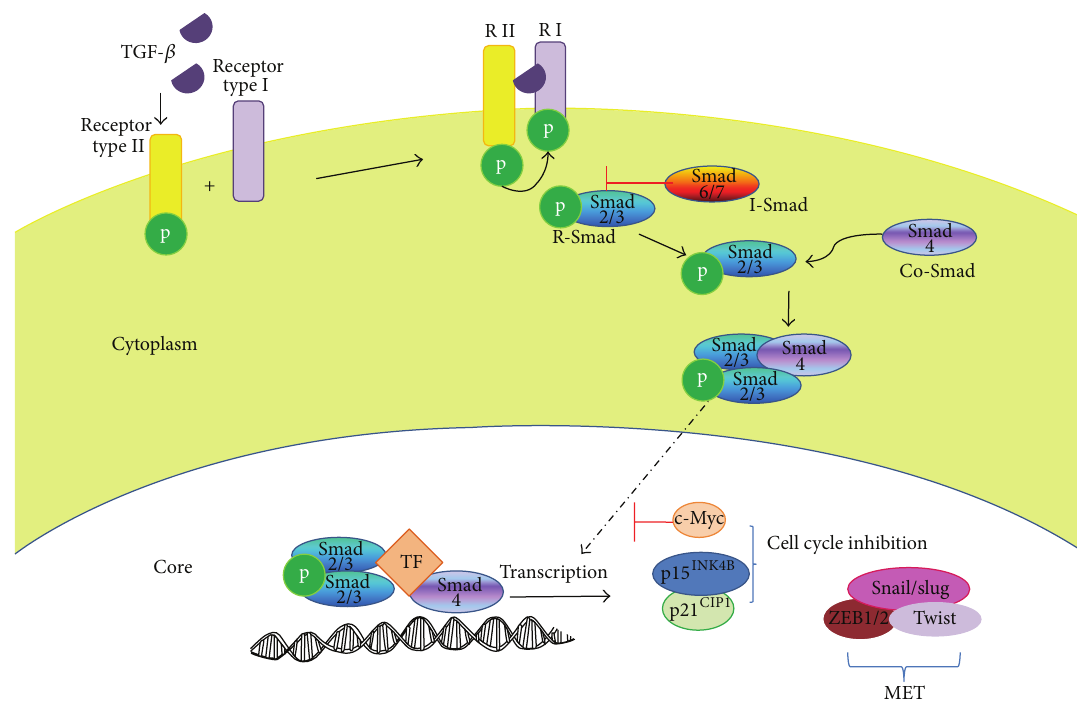
Figure 2: The TGF- 𝛽 canonical signaling pathway. After the ligand binds to T 𝛽 RII, the TGF- 𝛽 receptors are dimerized and recruit Smad proteins. The Smad2 and/or Smad3 complex is phosphorylated by T 𝛽 RI and forms a complex with Smad4. This complex subsequently translocates to the nucleus where it binds to specific transcription factors (TF) and induces the transcription of TGF- 𝛽 dependent genes.